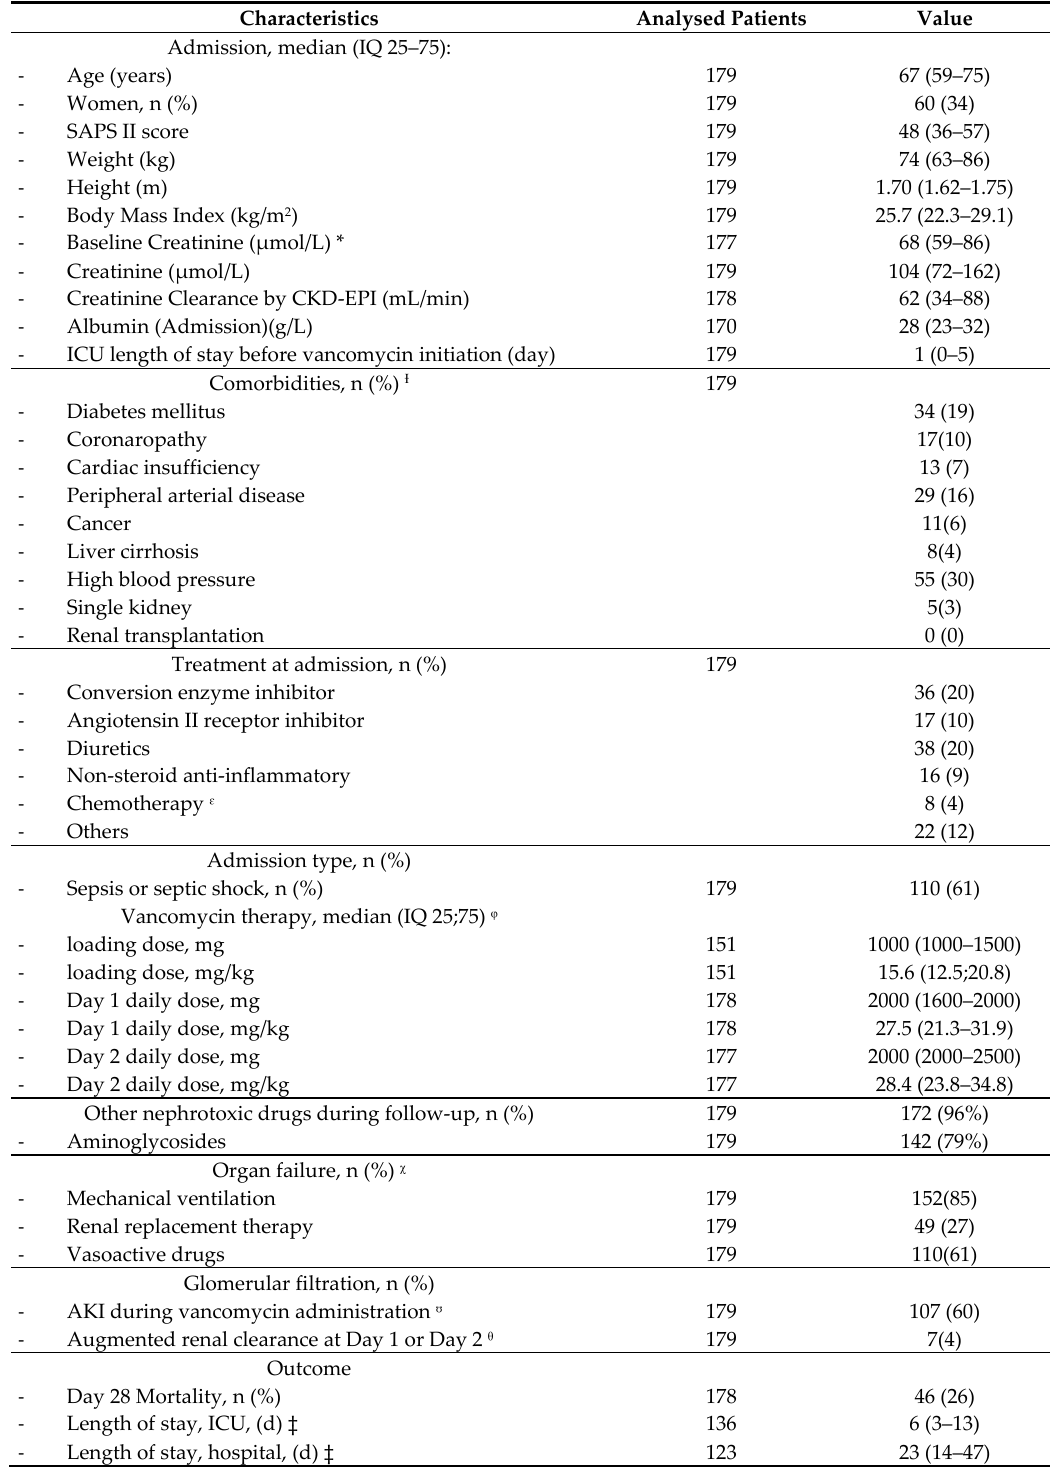
Table 2. Patient characteristics.